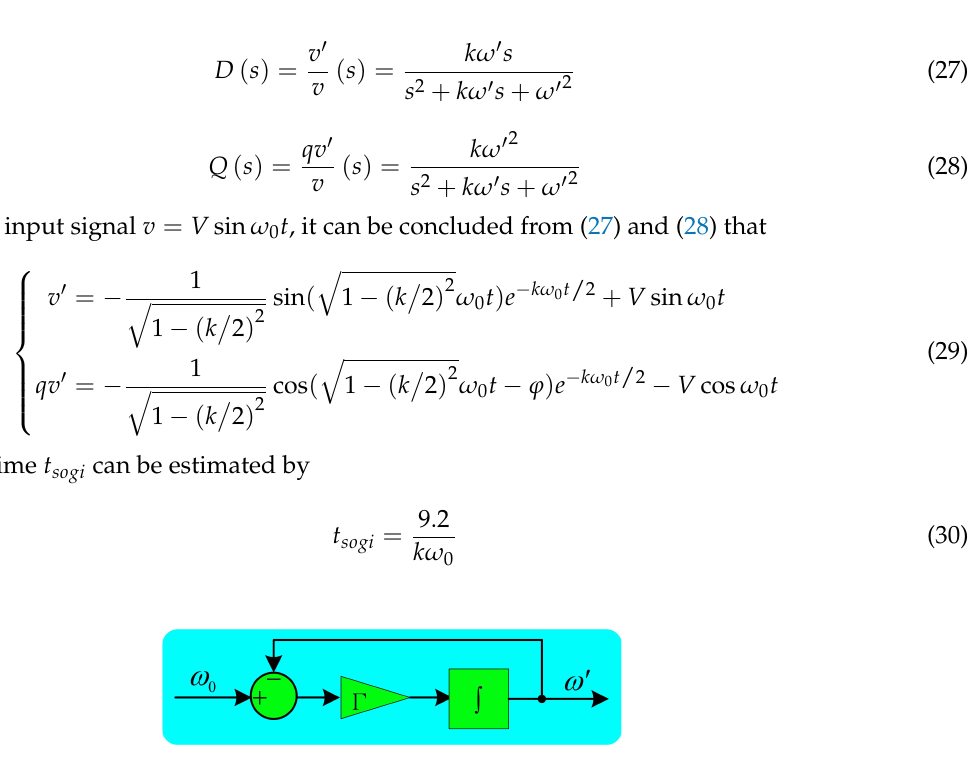
Figure 4. Simplified first-order linear frequency adaption system of the